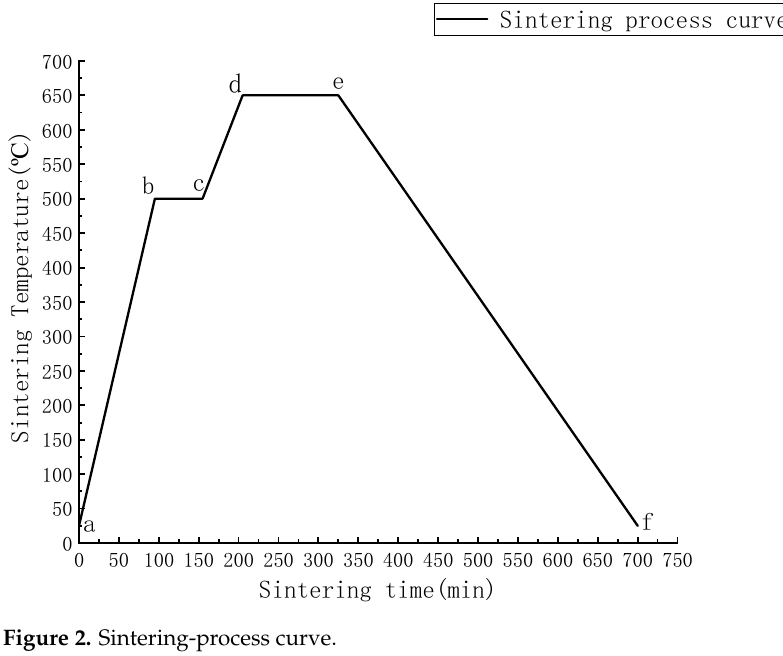
Figure 2. Sintering-process curve .